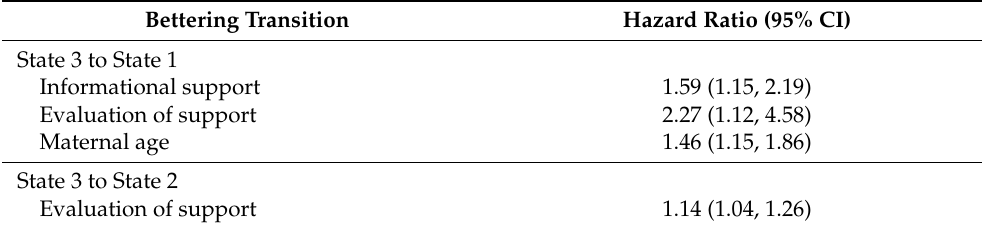
Table 6. The effects of covariates on PPD bettering